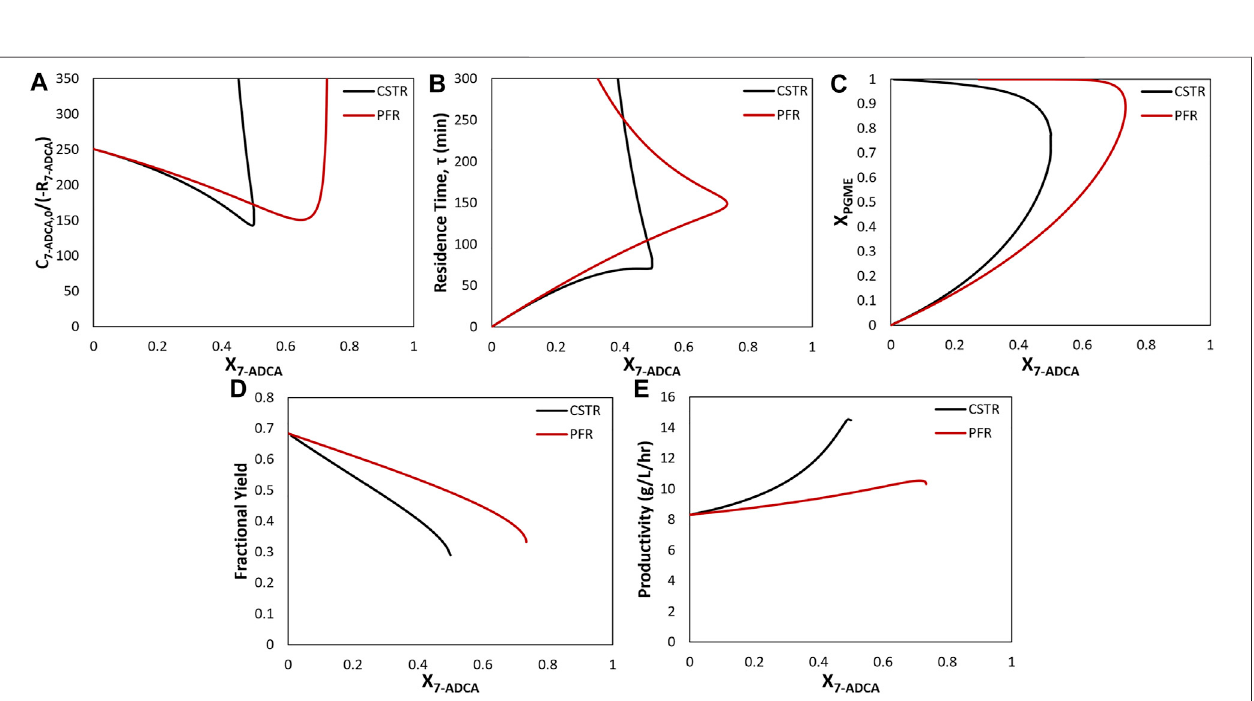
FIGURE 4 | Comparison of a CSTR (black) and PFR (red) for inlet conditions of 250 mM PGME and 100 mM 7-ADCA (A) Levenspiel plots showing the inverse 7- ADCAreactionrateasafunctionof7-ADCAconversion( X 7-ADCA ) (B) Residencetimes( τ )asafunctionof7-ADCAconversion( X 7-ADCA )derivedfromtheLevenspielplots. Residence time is calculated as the area under the curve for a PFR at a given X 7-ADCA . For the CSTR, residence time is calculated as the product of X 7-ADCA and the corresponding C 7-ADCA / ( -R 7-ADCA ) or the area of the rectangle under the curve at a given X 7-ADCA (C) PGME conversions ( X PGME ) corresponding to each X 7-ADCA in panel (A) . (D) Fractional yields obtained for X 7-ADCA in panel (A) . (E) Productivities obtained from Eq. 12 for the CSTR and Eq. 15 for the PFR at all X 7-ADCA values.